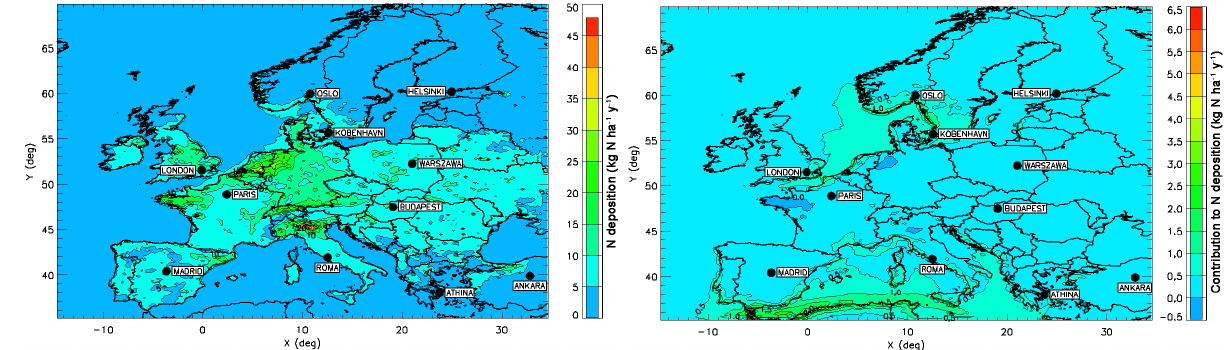
Figure 7. Annual nitrogen deposition only due to land-based emissions (left) and contribution of ship emissions to N deposition (right) (base case − no ship).